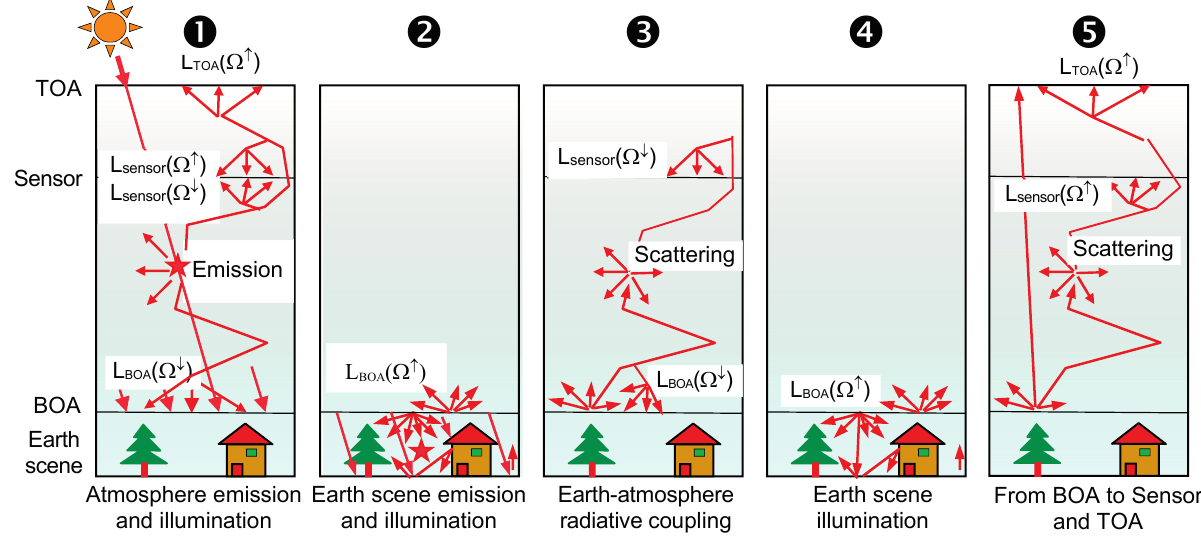
Figure 5. Five stages of the DART algorithm that models RT of the Earth-atmosphere